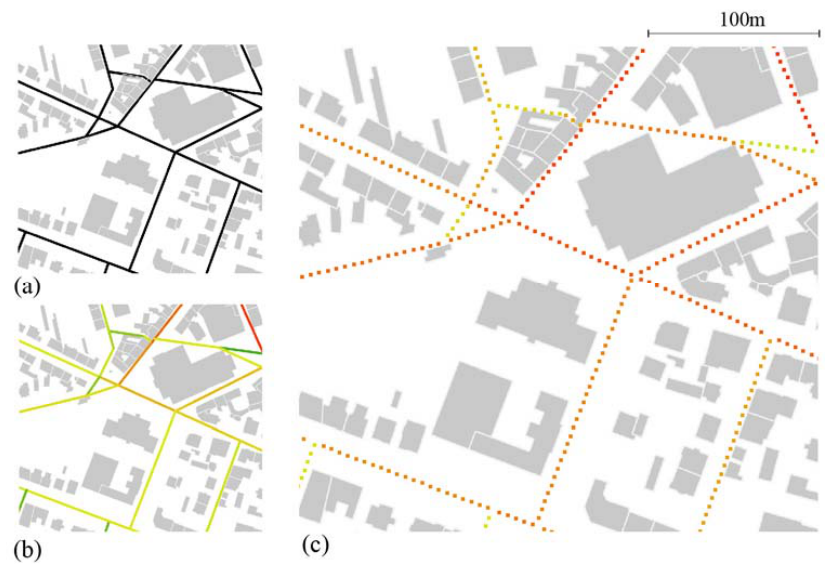
Figure 3. Discretization of the street network: ( a ) Segment map; ( b ) Betweenness R600 (red = high Betweenness, green = low Betweenness); ( c ) Street network discretized to evenly distributed points (at 5 m distance).